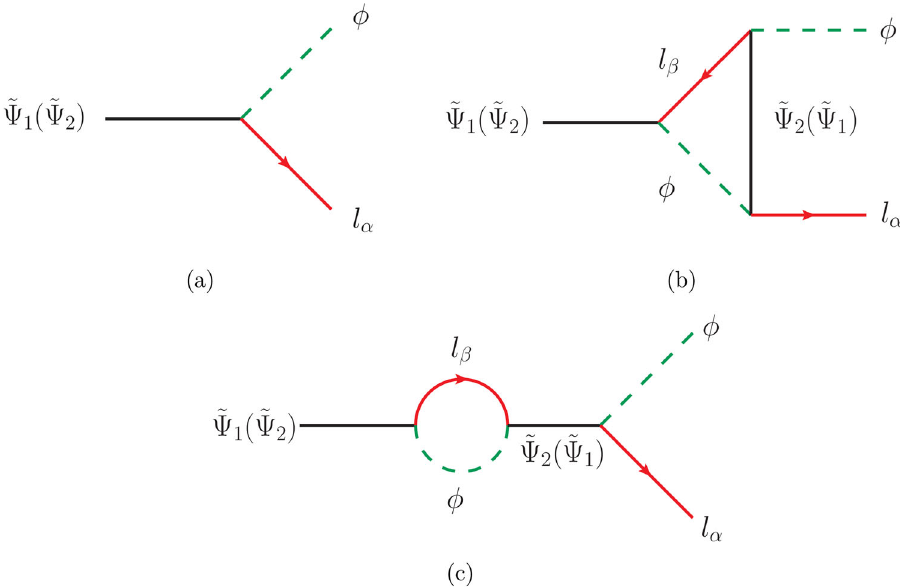
Fig. 1 Diagrams contributing to the CP -asymmetry (cid:13) 1 and (cid:13) 2 : a tree-level decay of ˜ (cid:9) 1 ( ˜ (cid:9) 2 ) , b vertex correction, c self-energy